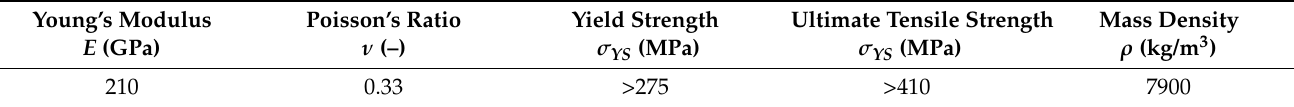
Table 1. Main mechanical properties of